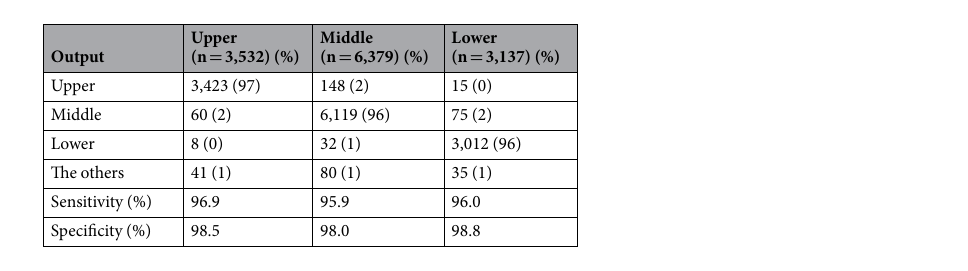
Table 3. Anatomical classification of stomach images by